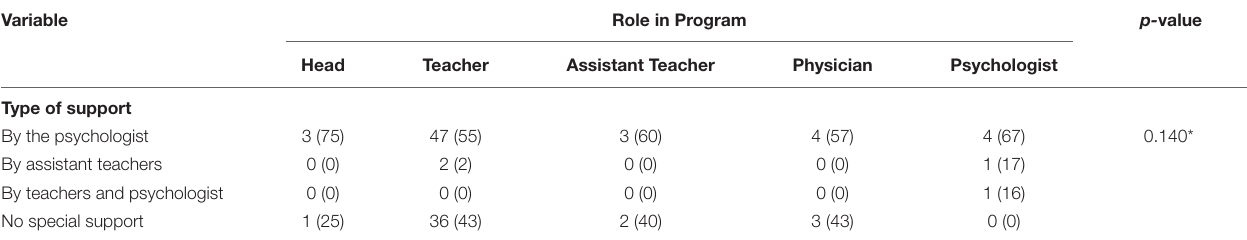
TABLE 3 | Relationship (chi square test) between type of support for children with disabilities and role in preschool program (responses from a total of 107 preschool personnel).